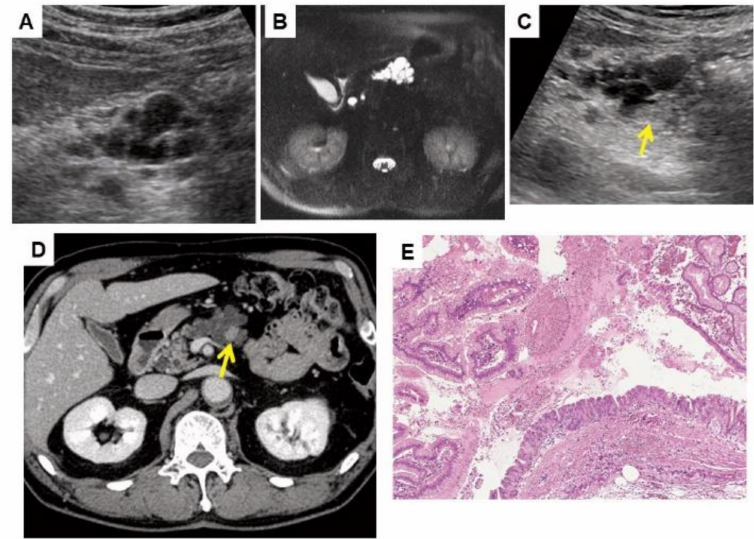
Figure 3. Images of a 62-year-old man who subsequently developed IPMN-HGD (patient No. 10 in Table 2). ( A ) Special pancreatic US at initial surveillance revealed a 40-mm multilocular cyst in the pancreatic body. ( B ) Abdominal MRI at initial surveillance revealed a multilocular cyst that was diagnosed as branched-duct IPMN. ( C ) Special pancreatic US 4.8 years after the initiation of surveillance revealed a 10 mm mural nodule (MN) (arrow) in the pancreatic cyst. The cyst size increased to 50 mm. ( D ) Contrast-enhanced CT revealed enhancement of the MN (arrow). ( E ) Histological examination revealed IPMN-HGD in the resected pancreas (total pancreatectomy; hematoxylin-eosin stain, original magnification × 100). The patient was still alive without recurrence 9.3 years after surgical resection.